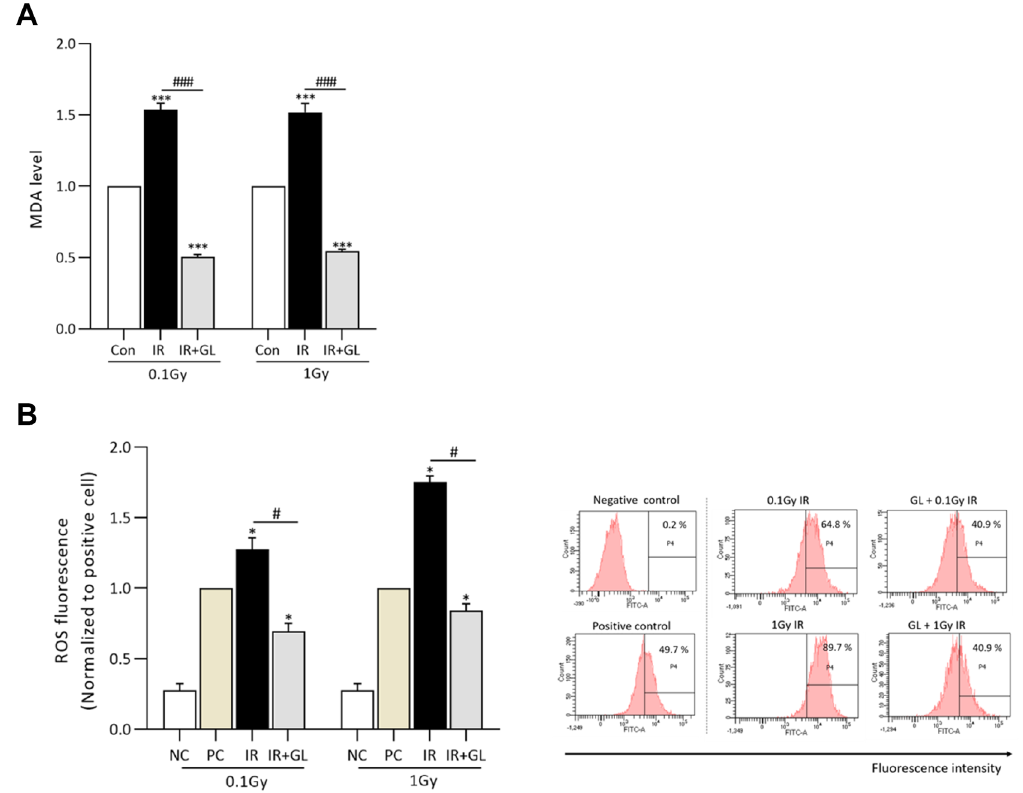
Figure 1. Oxidative stress measured by the MDA assay according to radiation dose. ( A ) The graph shows the normalized levels of MDA for the IR with/without GL groups compared to the control group. Oxidative stress was significantly higher in the IR only groups compared to the controls, whereas it was attenuated in the IR + GL groups. ( B ) ROS fluorescence was measured using flow cytometry at 24 h. It significantly higher in the IR only groups compared to the positive controls, whereas it was lower in the IR + GL groups. Measeured values normalized to the positive controls (= H 2 DCFDA stained cells). Results are expressed as means ± SEM from duplicate experiments (n = 5) performed in each group. The asterisk (*) indicates statistically significant differences between the control and IR groups (both IR only and IR + GL). The hash sign (#) indicates significant differences between the IR only groups and IR + GL groups. * p < 0.05, *** p < 0.001 # P < 0.05 and ### p < 0.001. Abbreviation: IR irradiation, GL glycyrrhizin, MDA malonaldehyde acid, ROS reactive oxidative species, NC negative control, PC positive